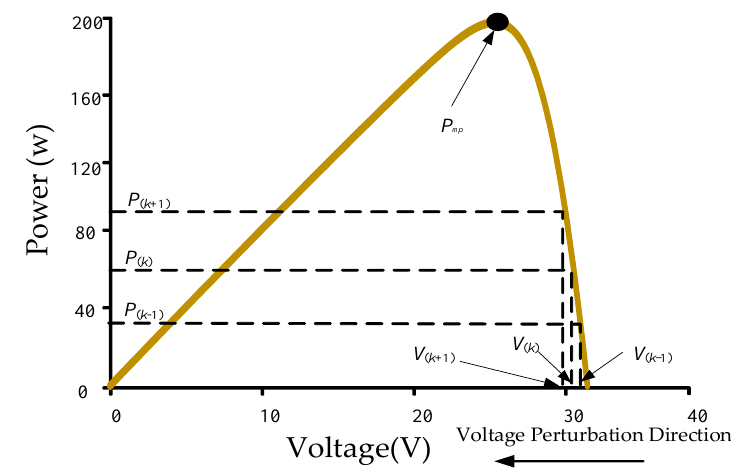
Figure 2. Work illustration for negative perturbation voltage of the perturbation and observation method.